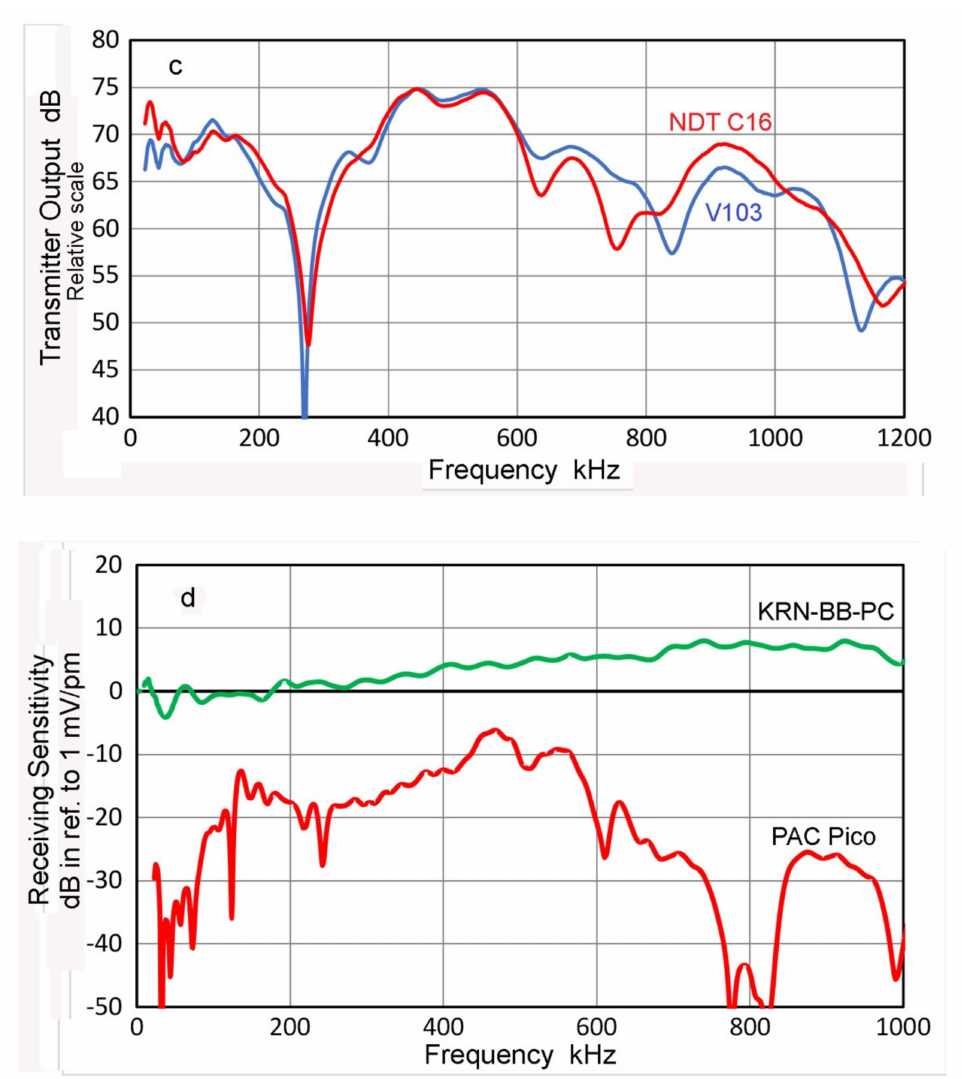
Figure 2. ( a ) Experimental set-up for attenuation measurement of asymmetric mode with a plate sample. A transducer glued to a hex rod is coupled to a plate edge using a pair of jigs. See also enlarged insert. Receiving sensor, a pulser and an oscilloscope are also visible. ( b ) Transmission sensitivity of two transducers, Olympus V101 (blue curve) and NDT C16. (green curve) in dB in reference to 1 nm/V. Normal incidence. Frequency spectrum of an excitation pulse is given in red. ( c ) Displacement output spectra of Olympus V103 (in blue) and NDT C16 (in red). Transducer mounted on a hex rod: 60 ◦ incidence. The dB scale is relative due to partial coupling to a calibrated receiver. ( d ) Rayleigh wave receiving sensitivity of two sensors, KRN-BB-PC (in green) and PAC Pico (in red). The dB scale is in reference to 1